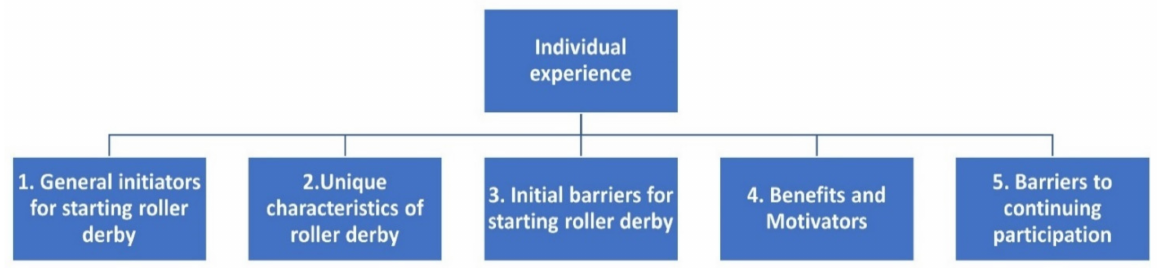
Figure 1. Overview of super-ordinate